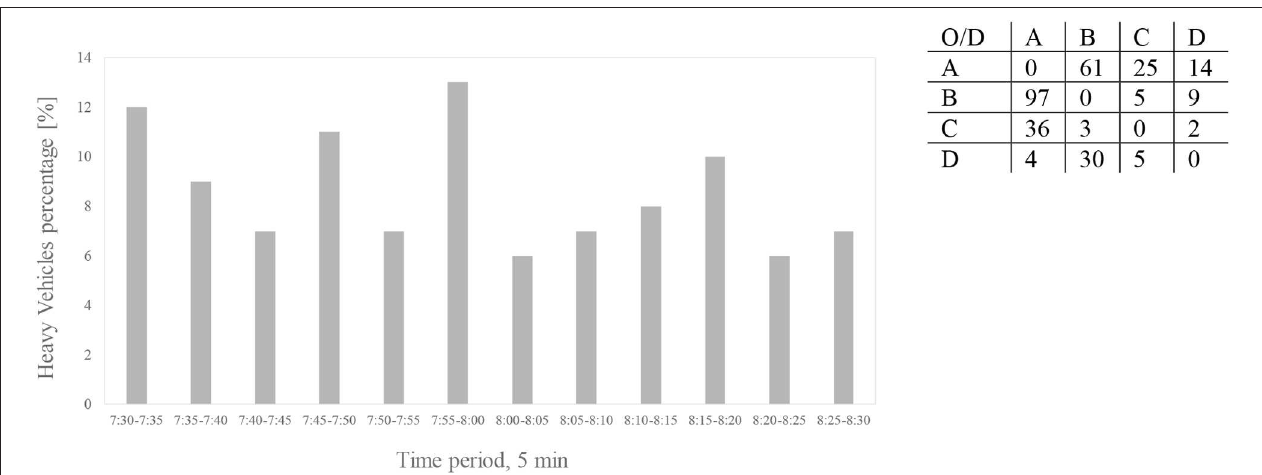
Frontiers in Built Environment |